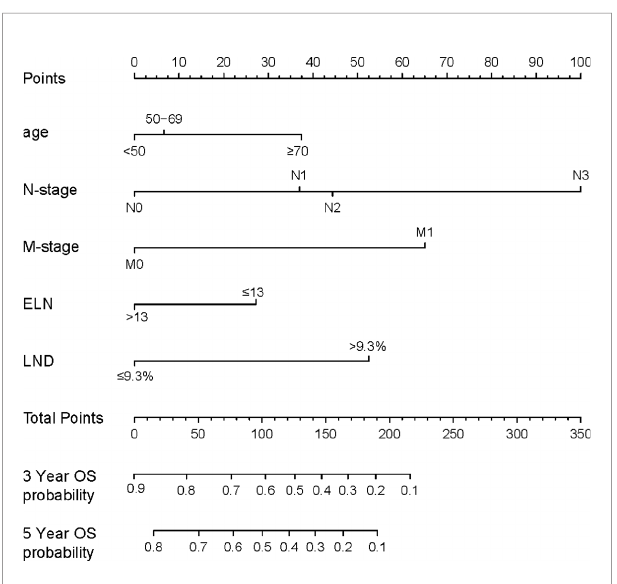
FIGURE 5 | A nomogram for predicting the OS. In order to use the nomogram, the value of each predicted value is determined by drawing a line up to the point reference line, these points are summed, and drawing a line down from the total point line to fi nd the predicted probability of OS. OS, Overall survival; LND, Lymph node density; ELN, Examined lymph node.